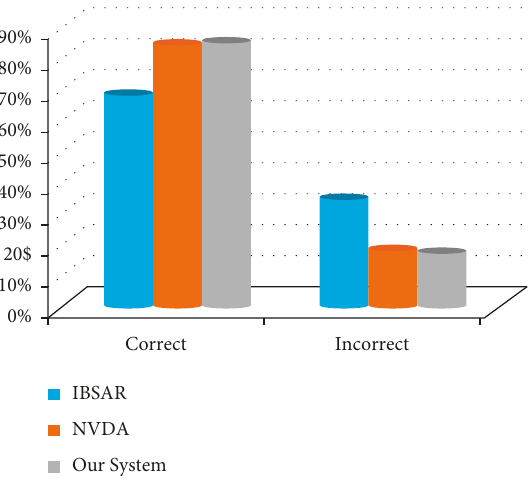
Figure 8: Isolated word test results.